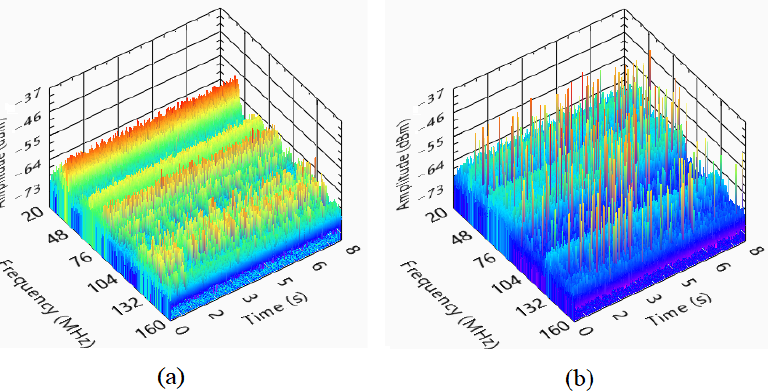
Figure 5. Spectrograms of ( a ) corona and ( b ) slot partial discharges. The spectrograms were registered in this work within eight seconds between 20 MHz and 160 MHz.